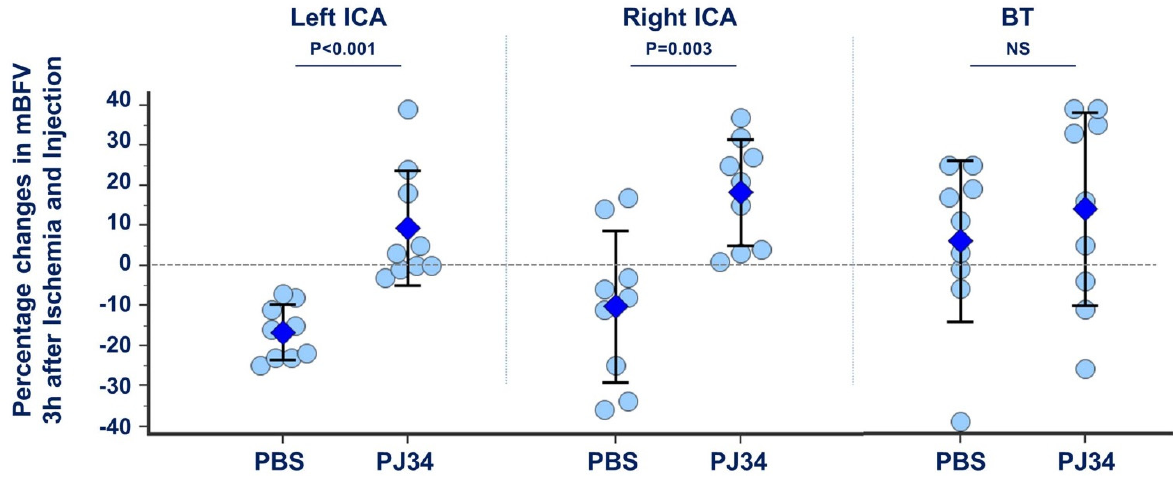
Figure 1. Relative changes in mBFV recorded in the three afferent arteries of the circle of Willis 3 h after ischemia and treatment. pMCAo produced an amputation of the vascular network, then the left ICA showed a drop in mBFV in PBS-treated mice. PJ34-treated mice did not show this drop; this was evocative of the establishment of the collateral supply through the cortical anastomoses between neighboring cerebral territories. In the right ICA, mBFV remained stable after ischemia, whereas PJ34 produced increased mBFV in both blood rerouting through the circle of Willis and then the cortical anastomoses. In the BT, no significant modification was recorded in PBS- and PJ34-treated mice (not significant—NS; n = 9 mice per group). Curr. Issues Mol. Biol. 2021 , 1 , FOR PEER REVIEW